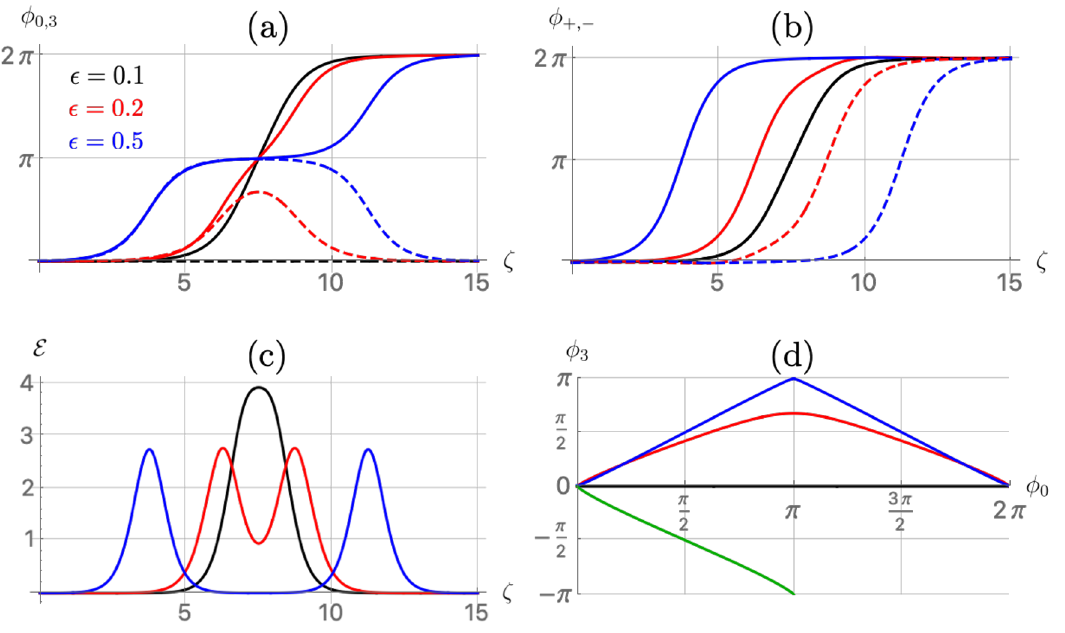
Figure 1 . Numerical solutions of CSLs (shown within one period) for β = π/ 16 and ‘ = 15 . The black, red, and blue curves correspond to (cid:15) = 0 . 1 ( η -CSL), 0 . 2 (dimer NA-CSL), and 0 . 5 (deconfined NA-CSL), respectively. The solid (dashed) curves show (a) φ 0 ( φ 3 ) and (b) φ + ( φ − ). (c) Energy densities without the CVE term. (d) Solutions plotted in the φ 0 - φ 3 plane. The green curve indicates the single d-CS with (cid:15) = 0 . 2